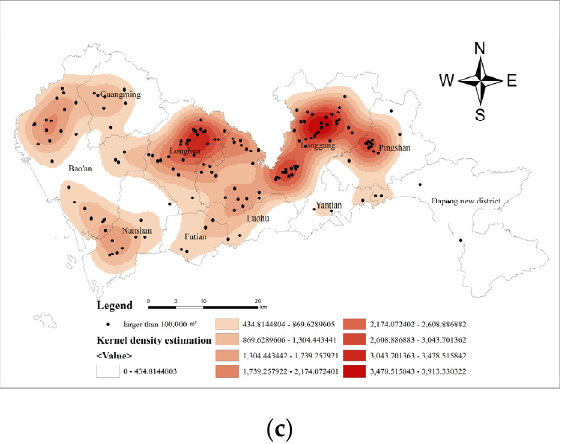
Figure A5. Spatial distribution of UR of different scales: ( a ) less than 50,000 m 2 ; ( b ) between 50,000 and 100,000 m 2 ; and ( c ) larger than 100,000 m 2 .